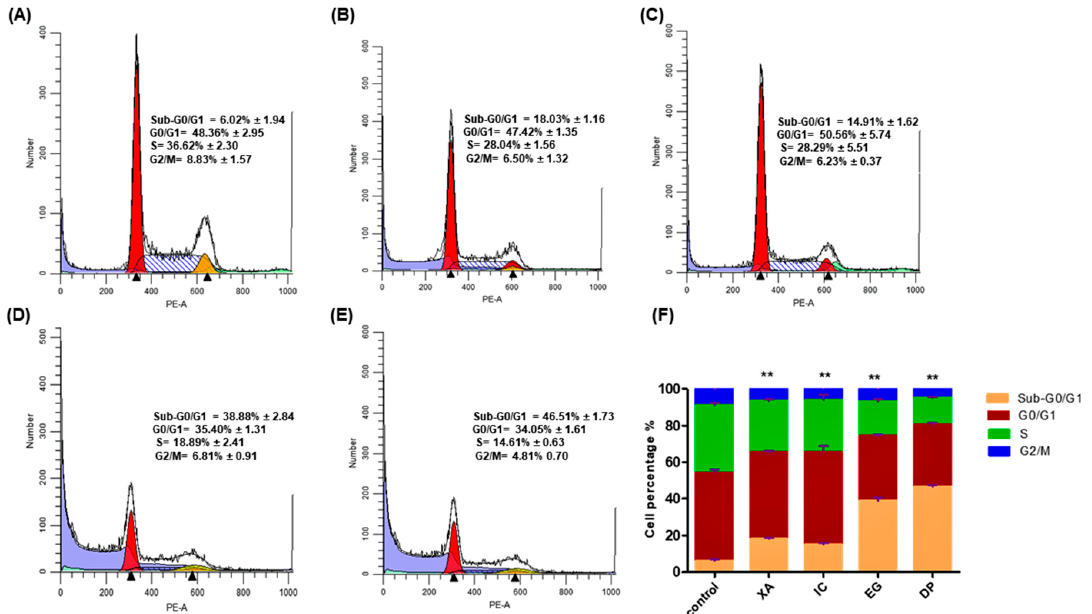
Figure 5. Cell cycle analysis by flow cytometry for HeLa cells treated with IC 50 of the different studied plant extracts for 48 h: ( A ) Control, ( B ) XA, ( C ) IC, ( D ) EG and ( E ) DP. While, ( F ) Comparative analysis among different plant extracts for Sub-G0/G1, G0/G1, S and G2/M Phases. The cell cycle distribution was analyzed by ModFit LT software. All results are expressed in the histogram as total percentages of cells from four different groups with mean ± SD of three independent determinations. All data collected from experiments were performed in three replicates and analyzed using the one-way analysis of variance (ANOVA) at a significance level of p < 0.05 and indicated by **.